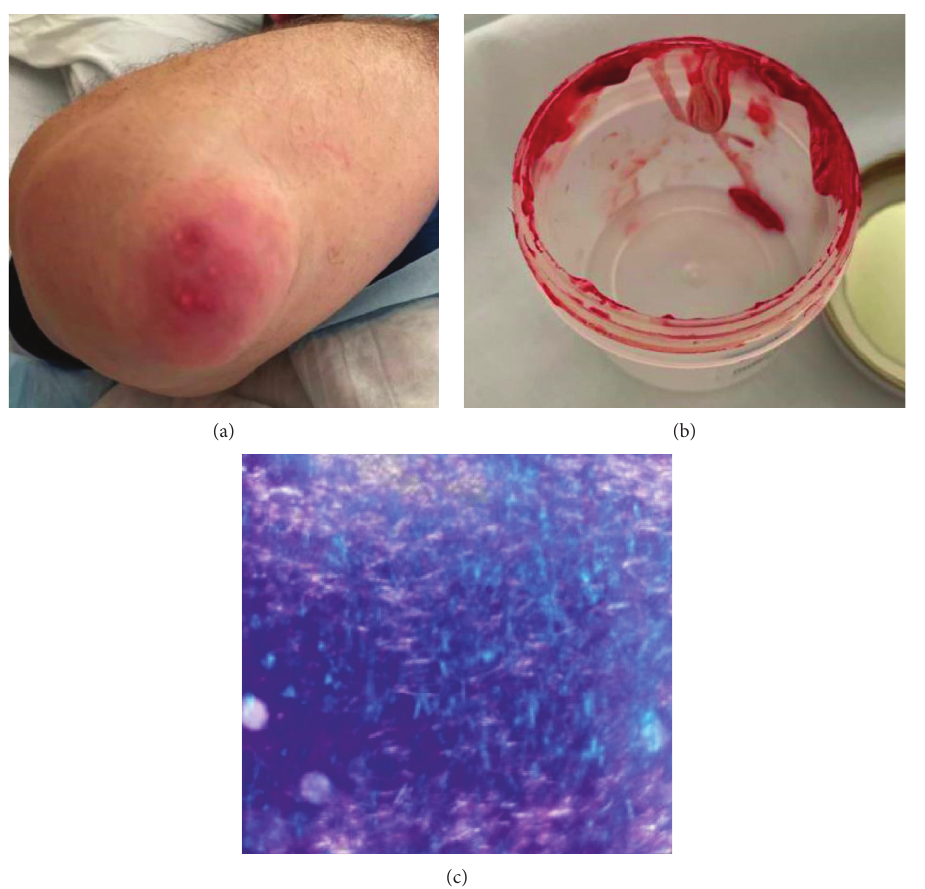
Figure 2: (a) Tophi involving the right elbow; (b) white, chalky deposit from aspirate; (c) monosodium urate monohydrate (MSU) crystals from a gouty tophus viewed under polarized light. Strong birefringence was noted along with the needle-shaped morphology classic for